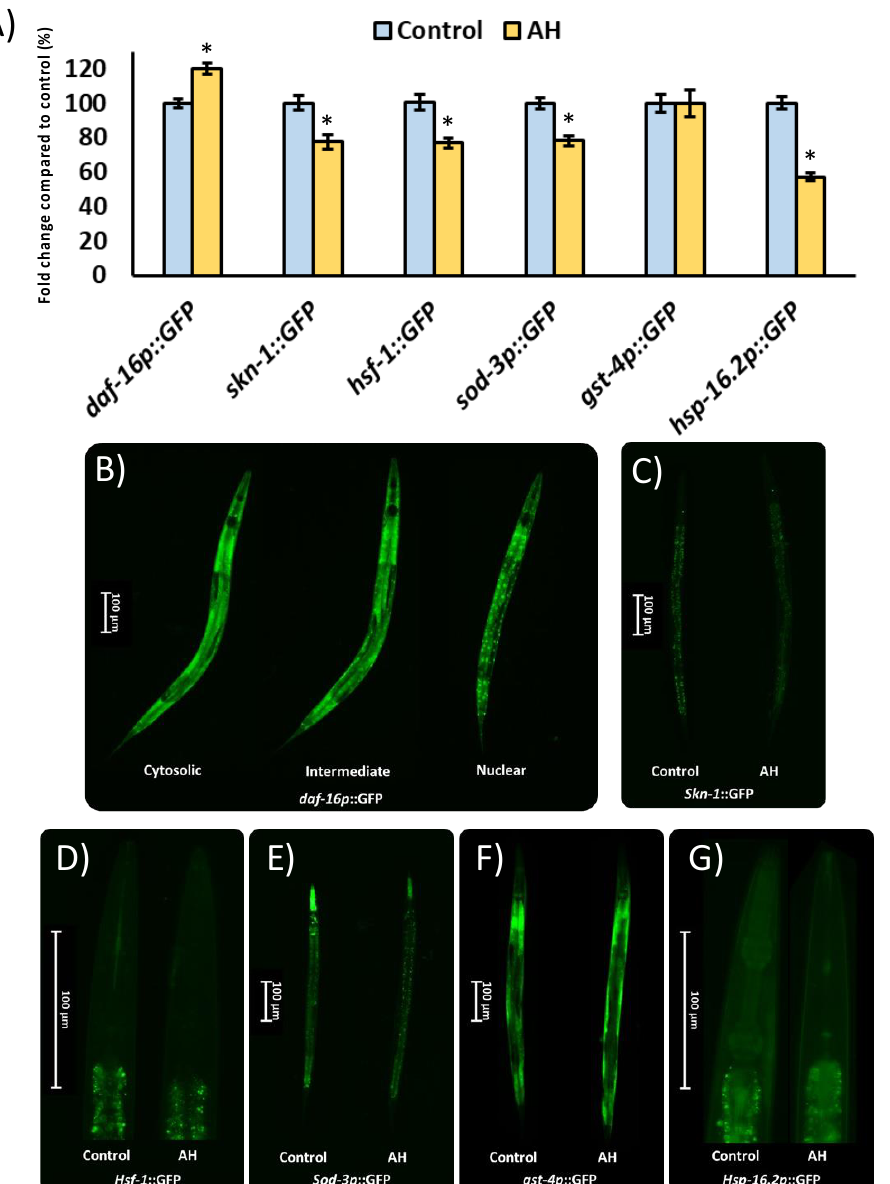
Figure 7. Influence of AH 100mg/mL on gene expression reported by GFP transgenic strains. ( A ) Fluorescence intensity quantification in the specific GFP-reporter strains. ( B ) Representative pictures of the semi-quantitative distribution of daf-16p ::GPG status. ( C ) Representative pictures for skn-1 ::GFP expression for both groups. ( D ) Representative pictures for hsf-1 ::GFP expression for both groups. ( E ) Representative pictures for sod-3p ::GFP expression for both groups. ( F ) Representative pictures for gst-4p ::GFP expression for both groups. ( G ) Representative pictures for hsp-16.2p ::GFP expression for both groups. Results are mean ± SEM. Asterisk (*) means statistically significant differences ( p < 0.05) against the control of the same